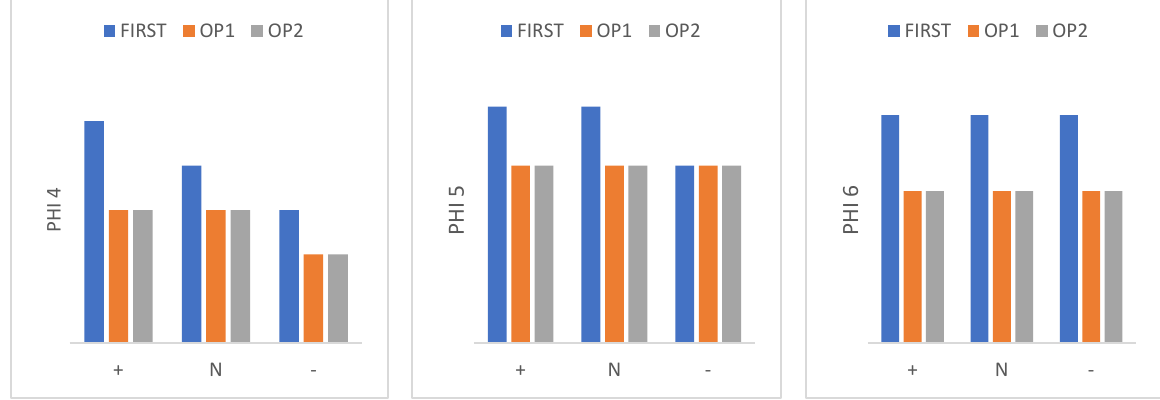
Fig. 16. Number of assets (facilities) (Owner)